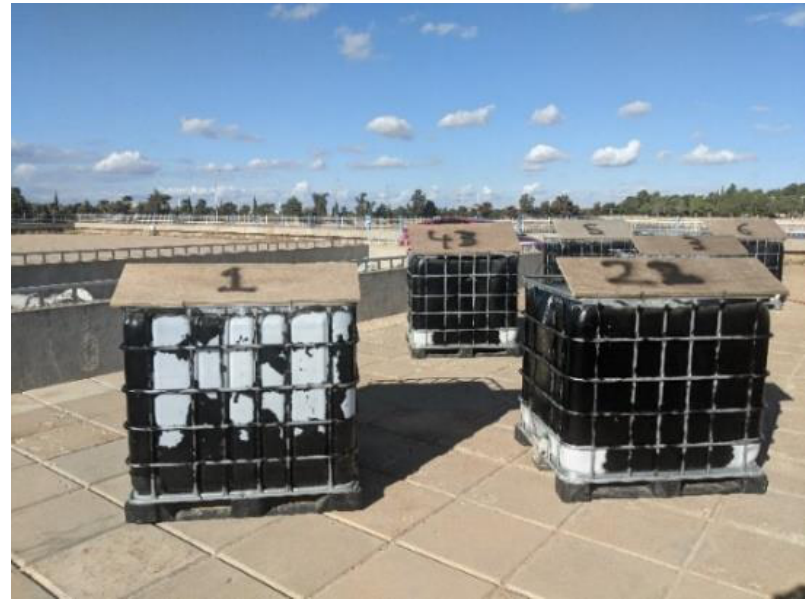
Figure 3. Water tanks